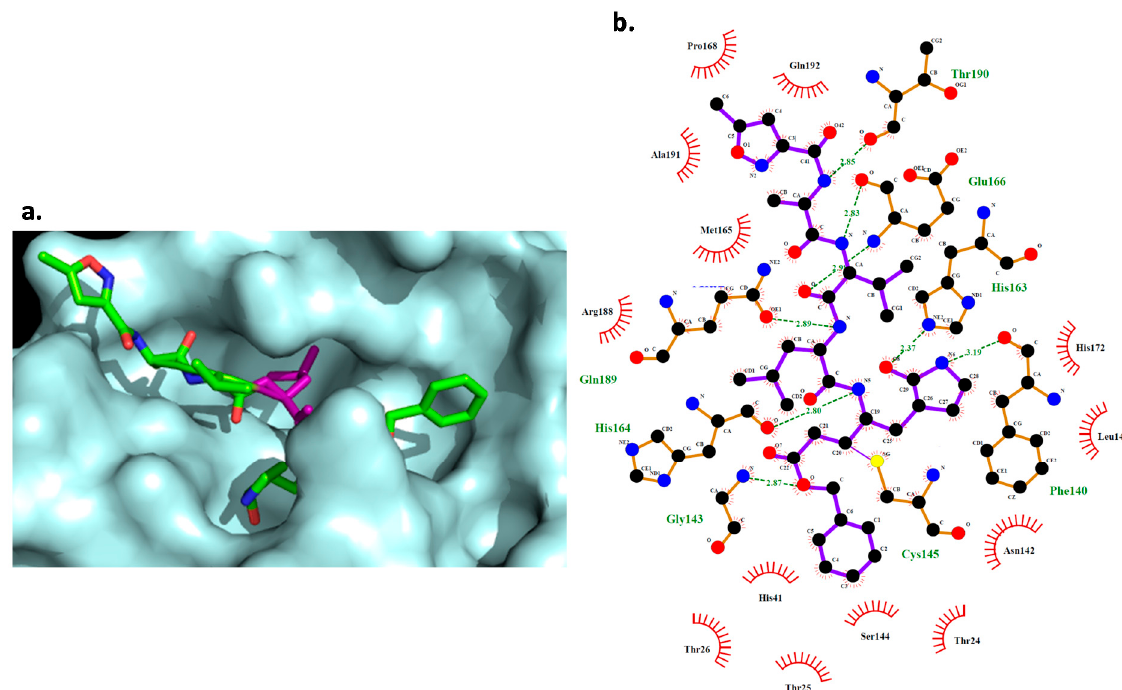
Figure 6. ( a ). N3 (green) interaction with the active site of Mpro (cyan). Leu residue is presented in pink. ( b ). 2D representation of the interaction between N3 and Mpro.